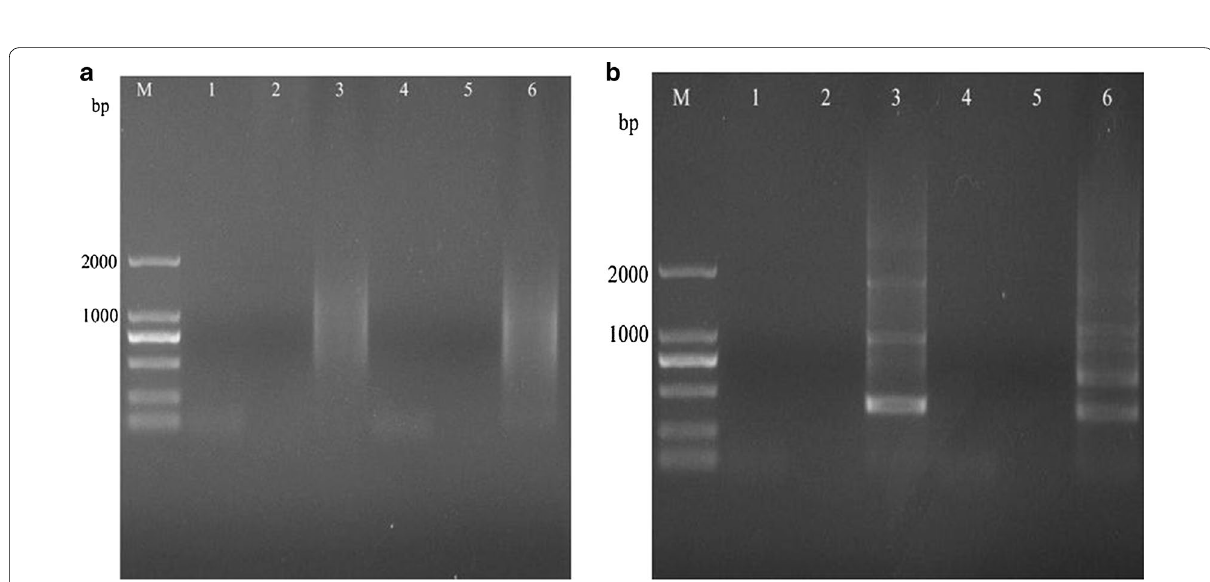
Fig. 5 Amplification results of a non-Tn5 insertion sample and non-linear amplification of sample 1. a Amplification of a non-Tn5 insertion sample with the method described in this study. Each step was repeated twice. Lanes 1 and 4 show the results of the first step. Lanes 2 and 5 show the results of the second step. Lanes 3 and 6 show the results of the third step. b Amplification results of sample 1 without linear amplification. Each step was repeated twice. Lanes 1 and 4 show the results of the first step. Lanes 2 and 5 show the results of the second step. Lanes 3 and 6 show